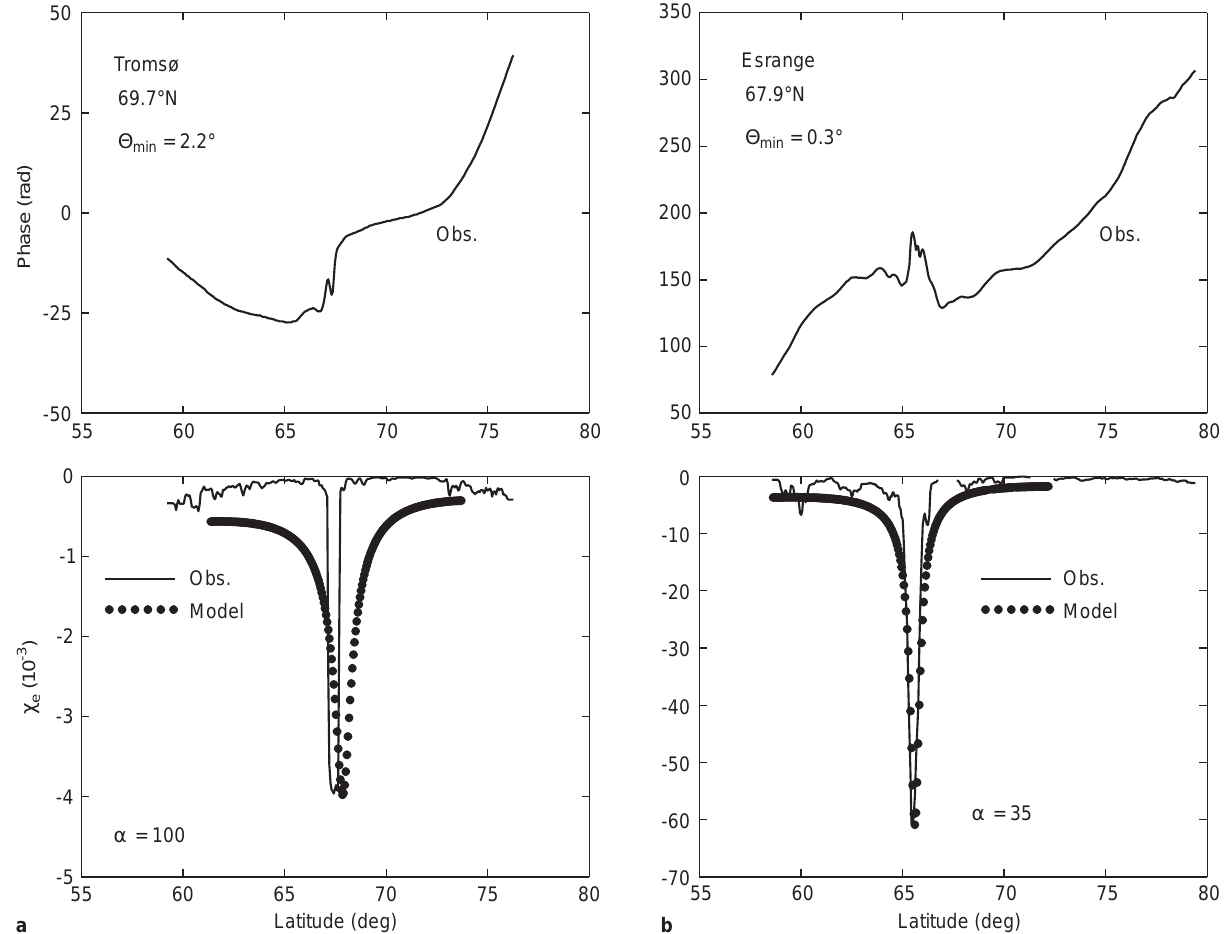
Fig. 3. Same as Fig. 2 for a satellite passage at Tromsø and the other